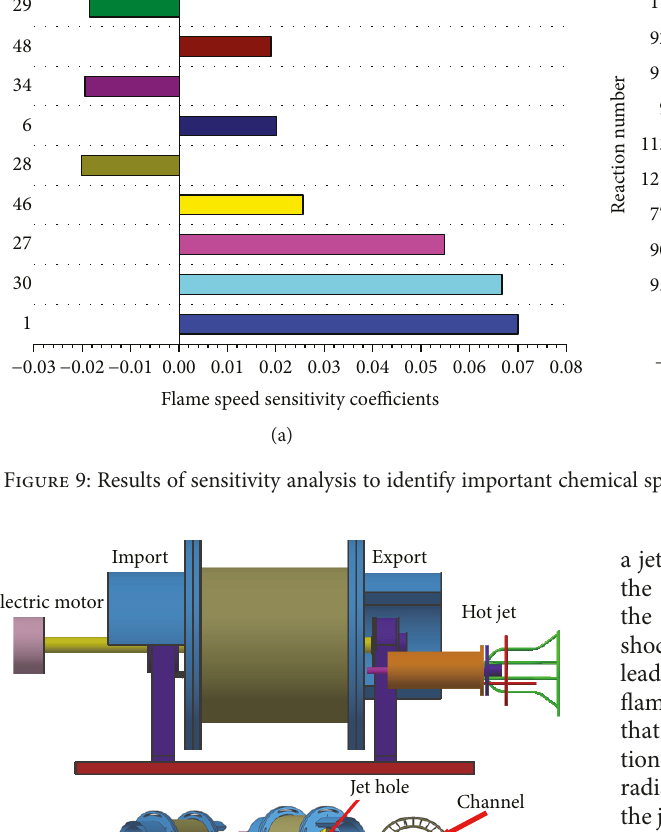
Figure 10: The physical model of full-scale